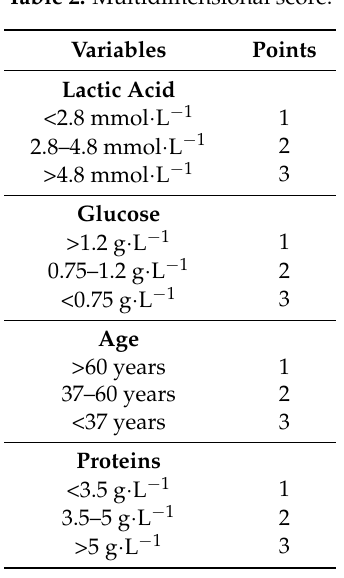
Table 2. Multidimensional